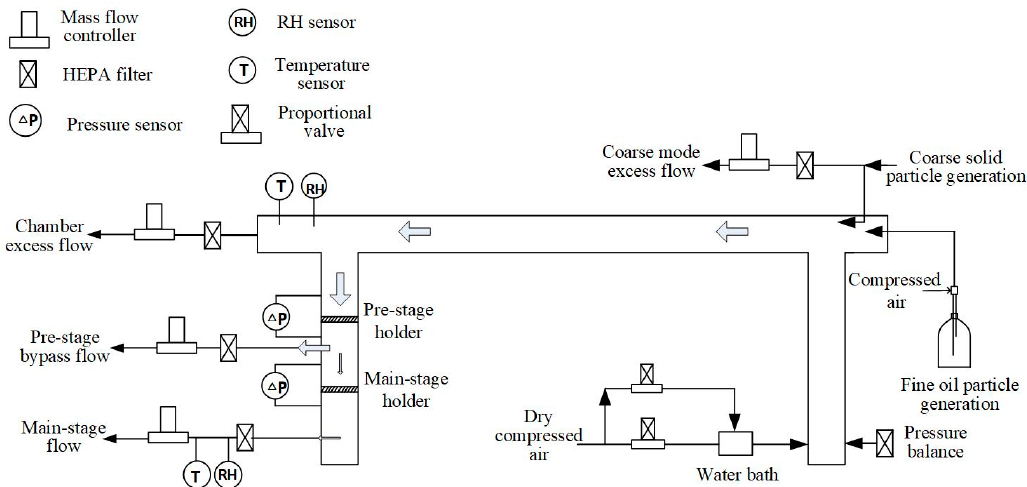
Figure 4. Schematic of the two-stage filtration system.